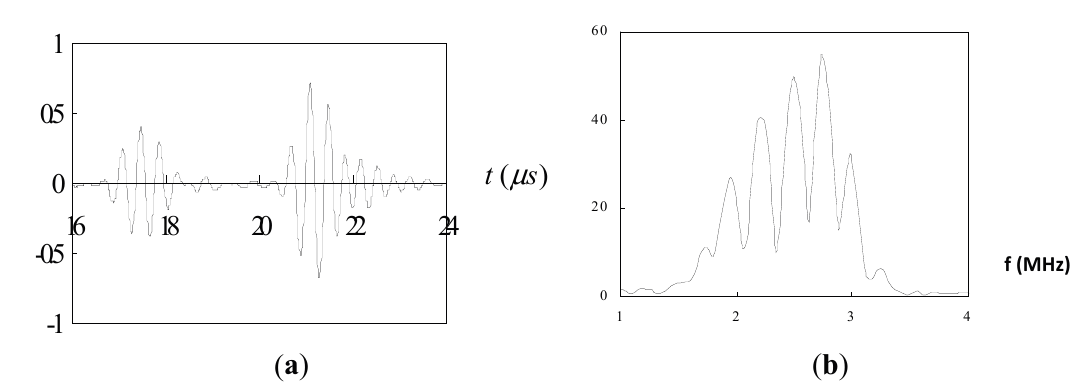
Figure 10. Reflection from a surface crack with 1 mm crack depth using 5 MHz longitudinal wave: ( a ) time domain; ( b ) frequency